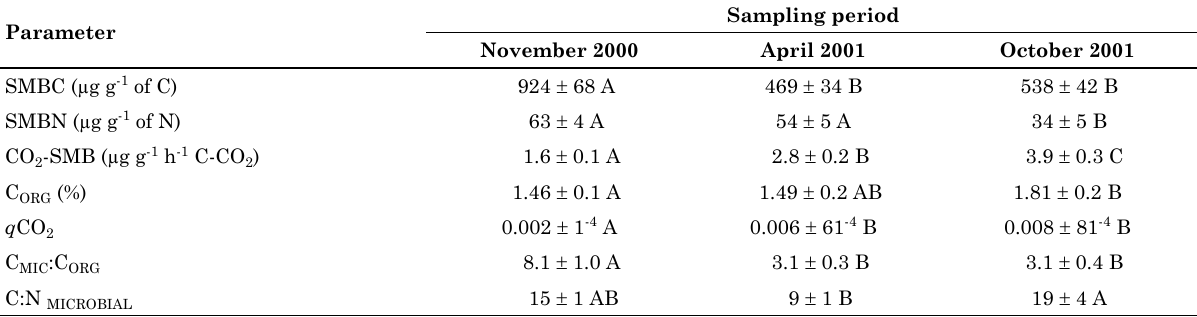
Table 3. Soil microbial biomass carbon (SMBC), soil microbial biomass nitrogen (SMBN), microbial biomass basal respiration (CO 2 -SMB), soil organic carbon (C ORG ), metabolic quotient ( q CO 2 ), soil C MIC :C ORG ratio, and C:N MICROBIAL ratio (depth of 0-10 cm) under a 15-year-old secondary forest